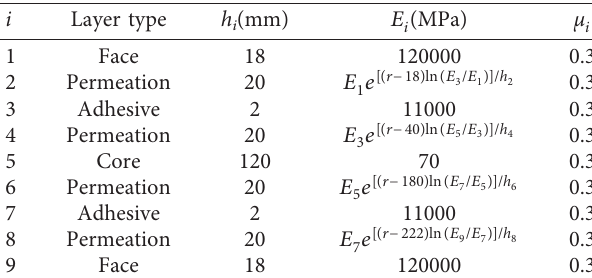
Table 1: The thickness and material property for each layer in the sandwich arch with nine layers.